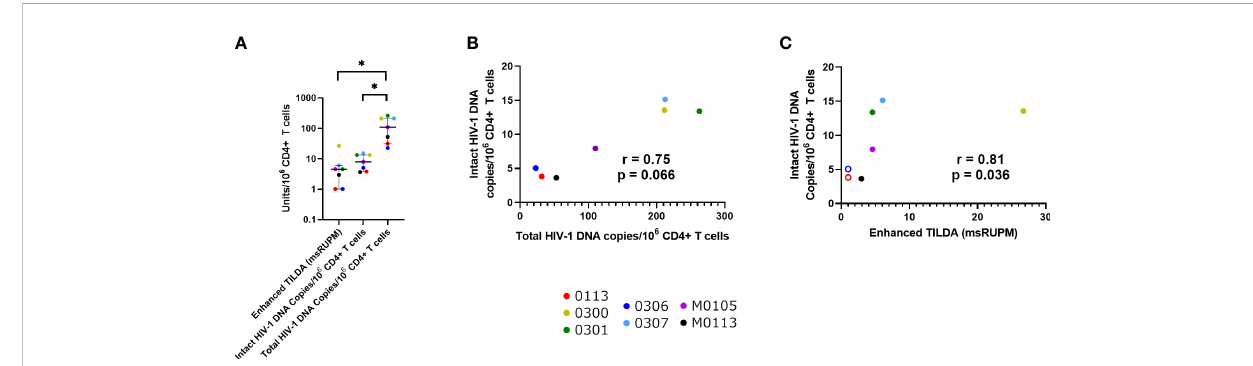
FIGURE 1 Quanti fi cation of the proviral reservoir in participants with HIV-1 subtype B (n = 7/10), using the enhanced TILDA and IPDA. (A) The levels of multiply spliced RNA producing units/10 6 CD4+ T cells(msRUPM), and the levels of intact and total HIV-1 DNA copies/10 6 CD4+ T cells. Median and IQR are shown. Signi fi cance is determined by a Friedman test with Dunn ’ s multiple comparison test (*p < 0.05). Correlations between Intact HIV-1 DNA copies/10 6 CD4+ T cells and (B) Total HIV-1 copies and (C) multiply spliced RNA-producing units/10 6 CD4+ T cells. Open circles represent undetectable